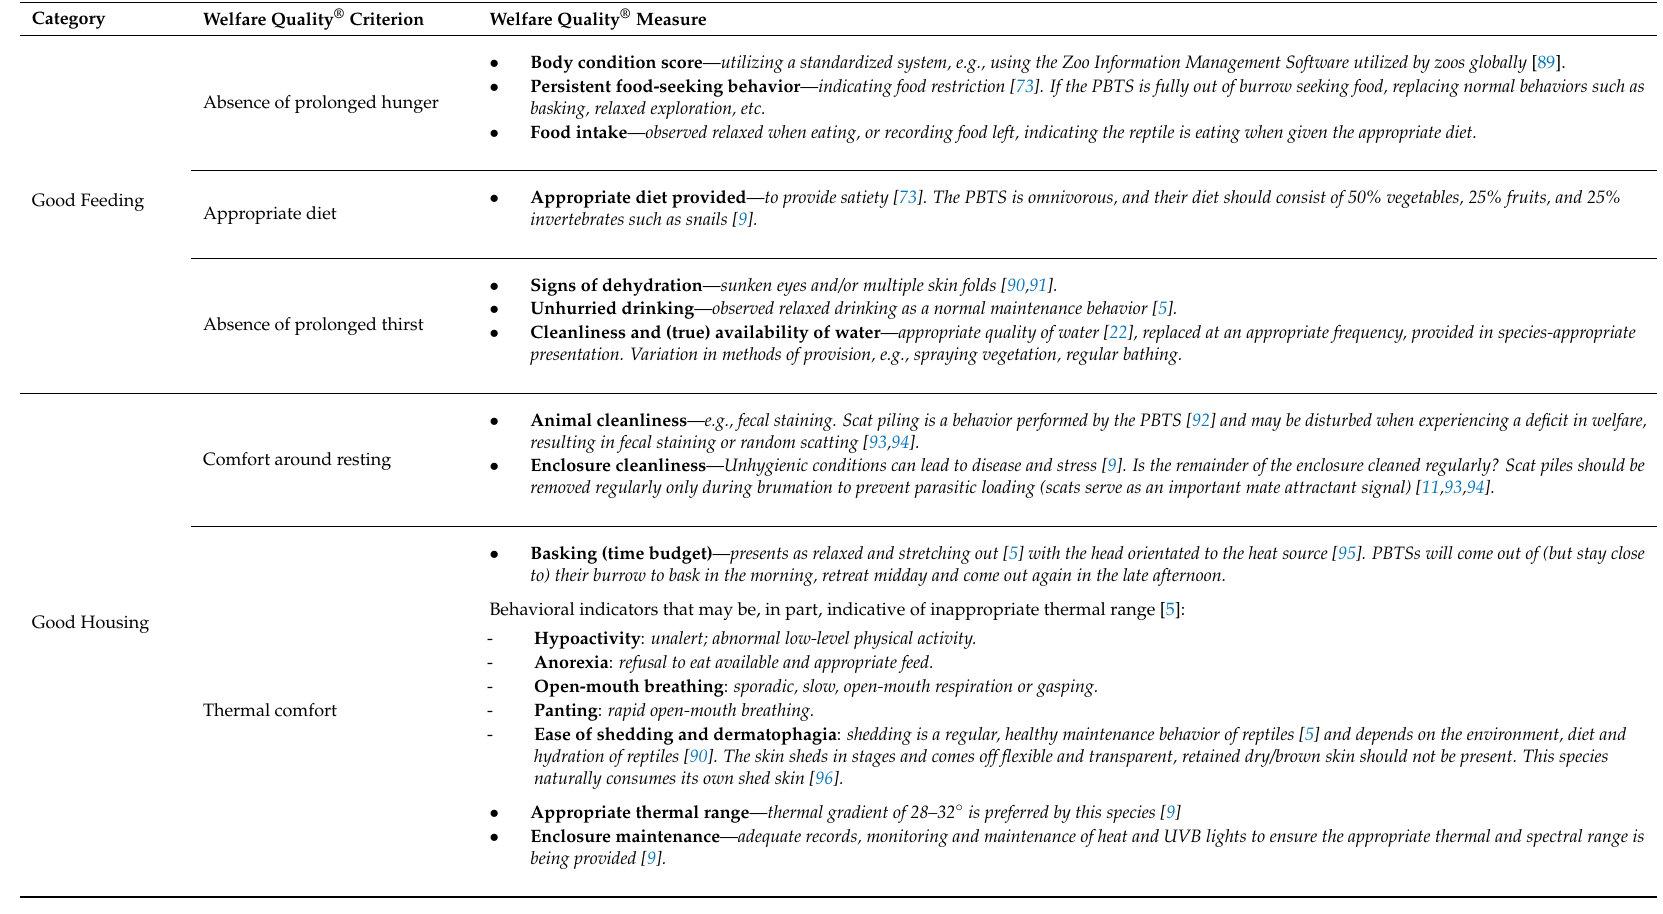
Table 1. Application of the welfare assessment tool of the pygmy blue-tongue skink (PBTS, Tiliqua adelaidensis ) based on the Welfare Quality ® framework.